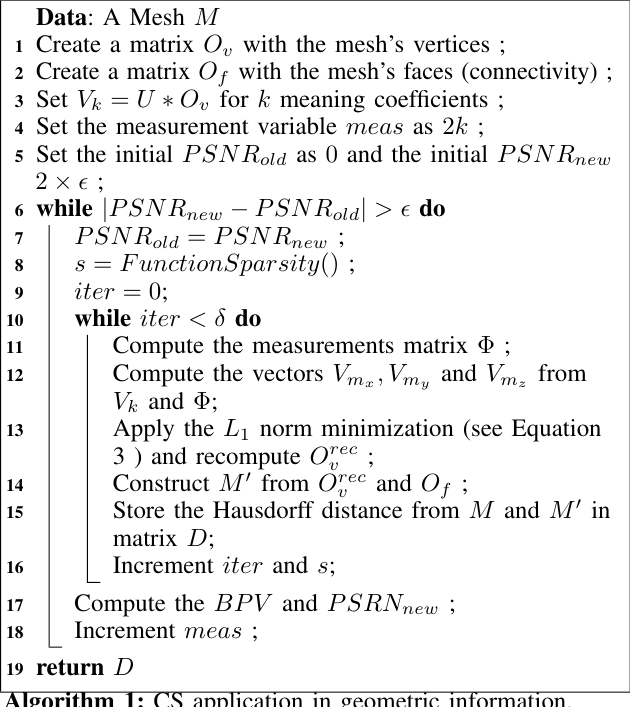
Algorithm 1: CS application in geometric